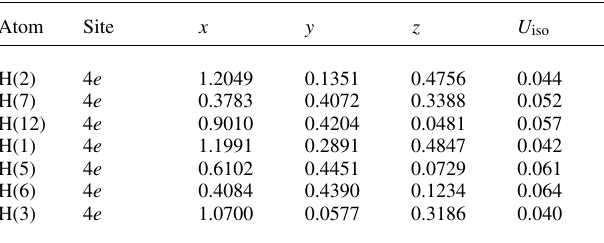
Table 2. Atomic coordinates and displacement parameters (in Å 2 )